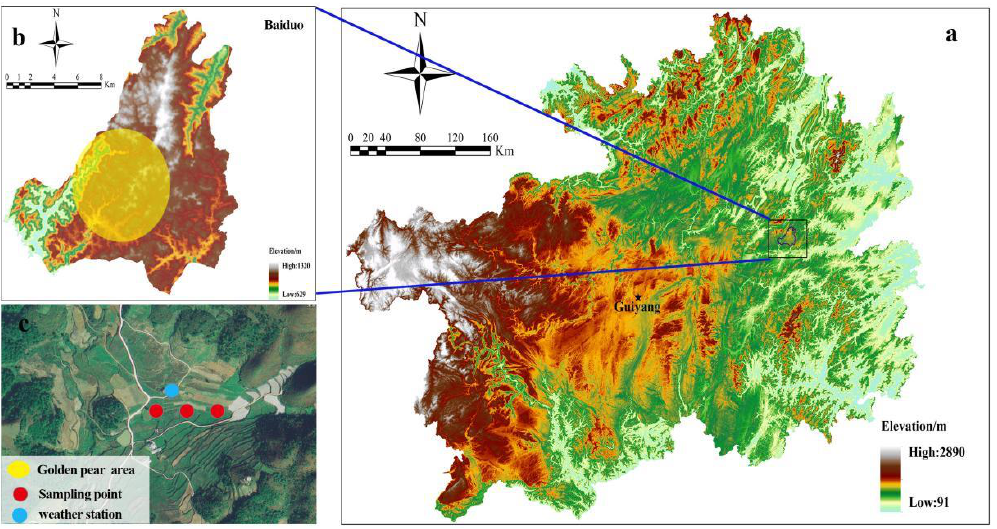
Figure 1. Location of the study area in Guizhou Province ( a ). The yellow area in the upper left corner represents the golden pear growth area ( b ), the red point in the lower left corner represents the sampling point, and the blue point represents the weather station ( c